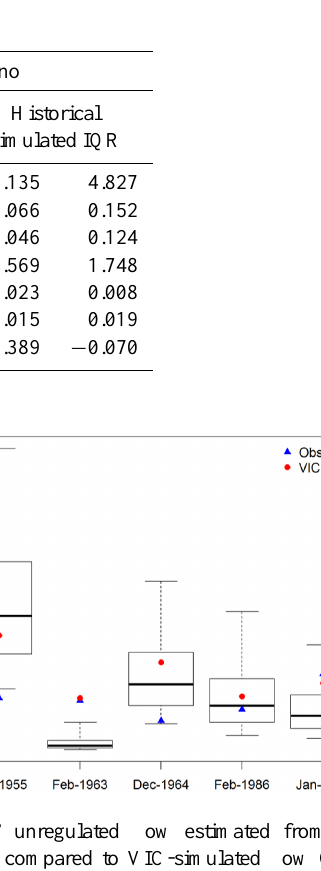
Table 3. Summary of derived model covariates for Eqs. (2) and (3) based on historical observations (historical observed) and using historical